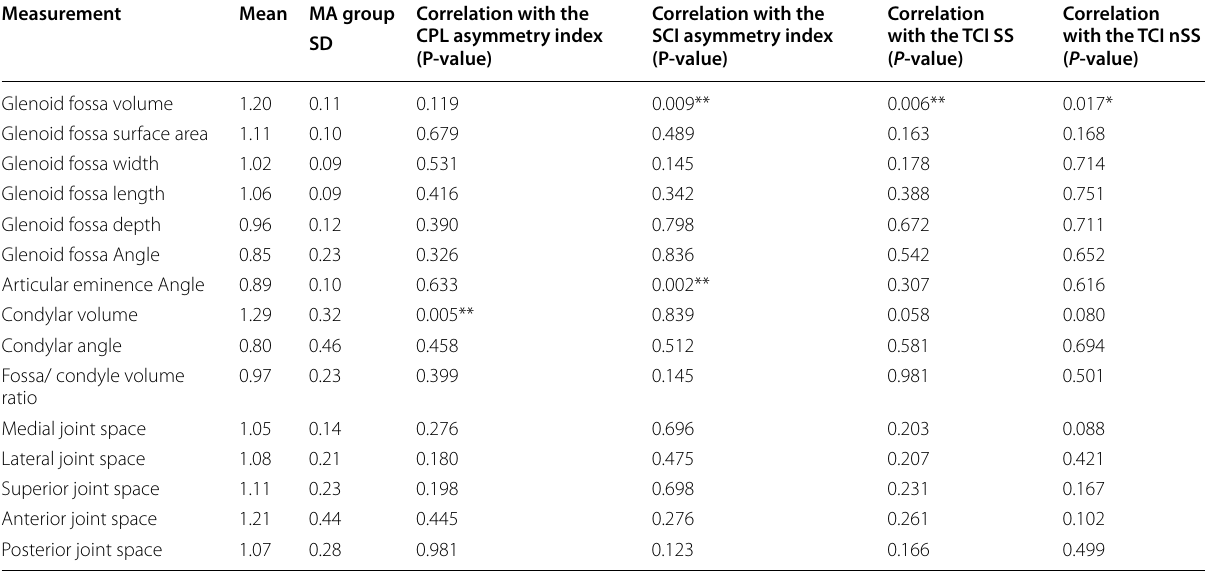
Asymmetry index